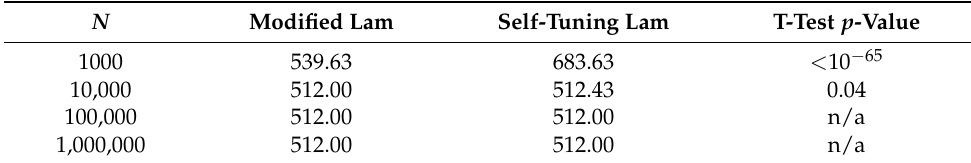
Table 6. Average solution cost for the Trap problem.